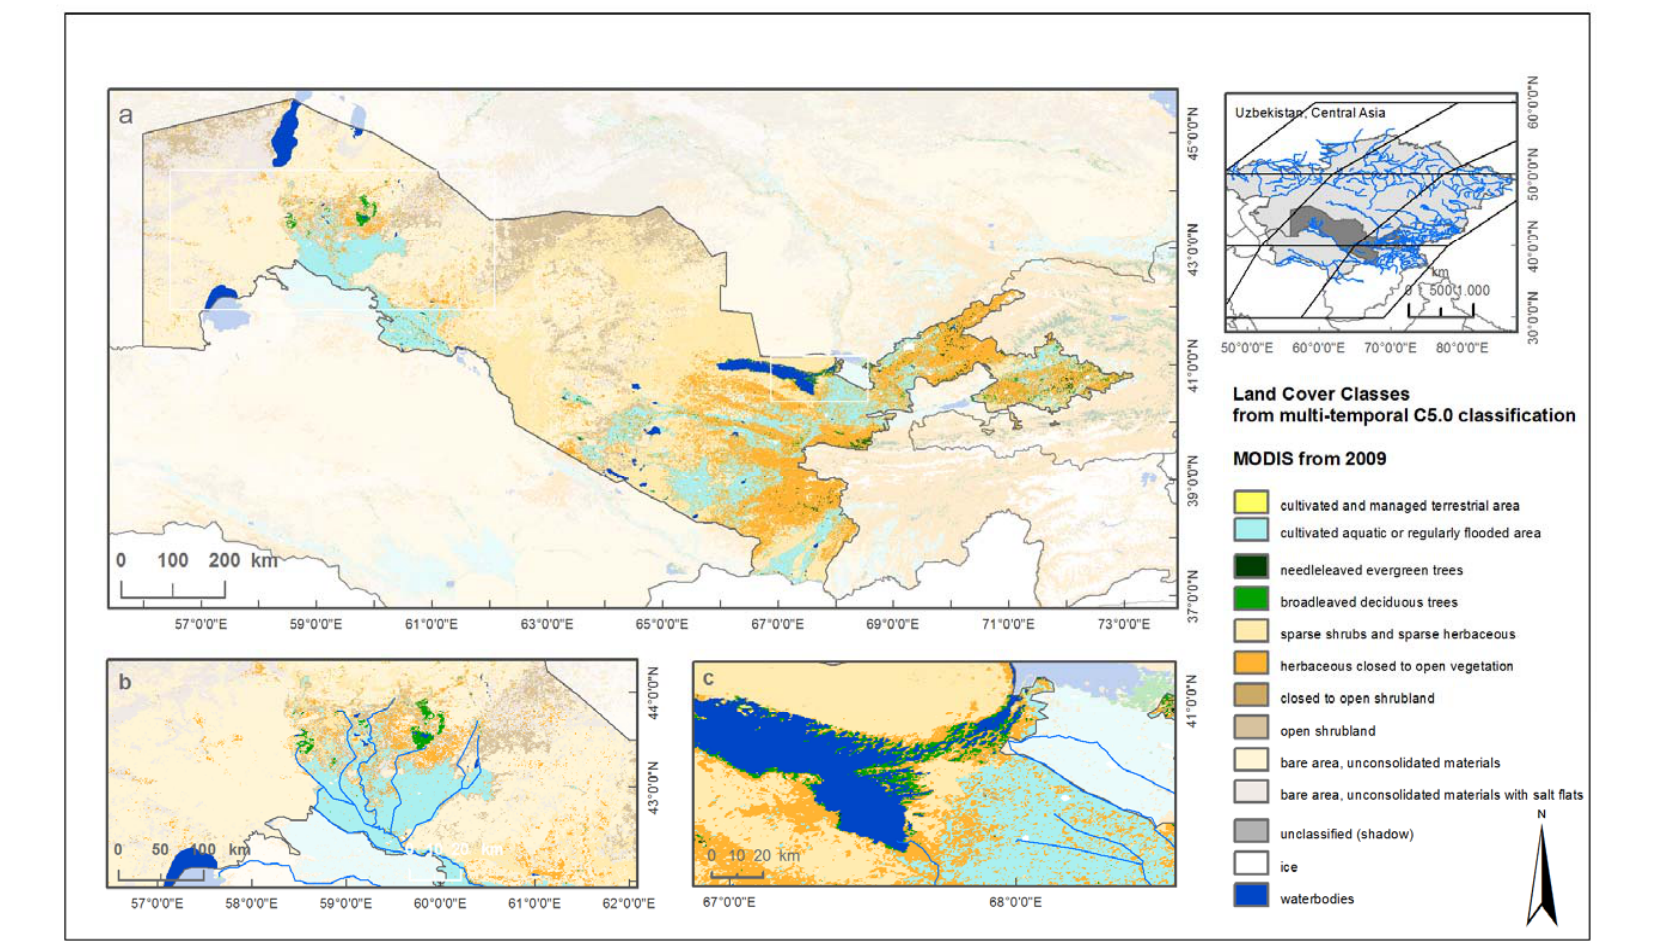
Figure 6. Classification result of TWOPAC run with multi-temporal MODIS 8 tiles mosaic (2009) for Central Asia: Overview of the classification result for Uzbekistan ( a ); details on specific land cover types—cultivated area and natural vegetation ( b , c